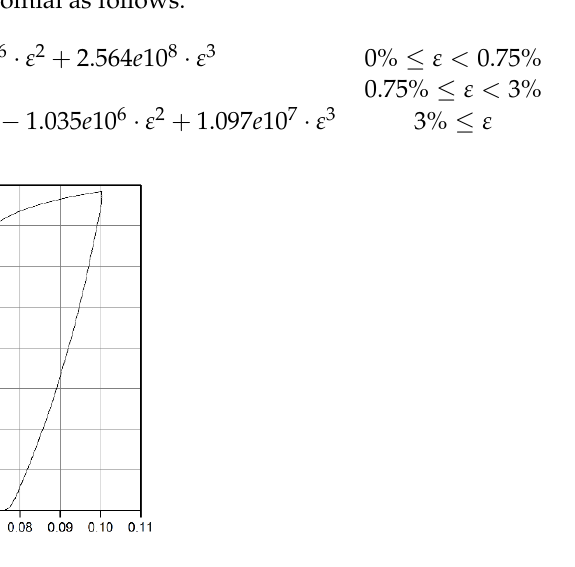
Figure 2. Strain versus stress curves of shape memory alloy (SMA) in an ambient environment.